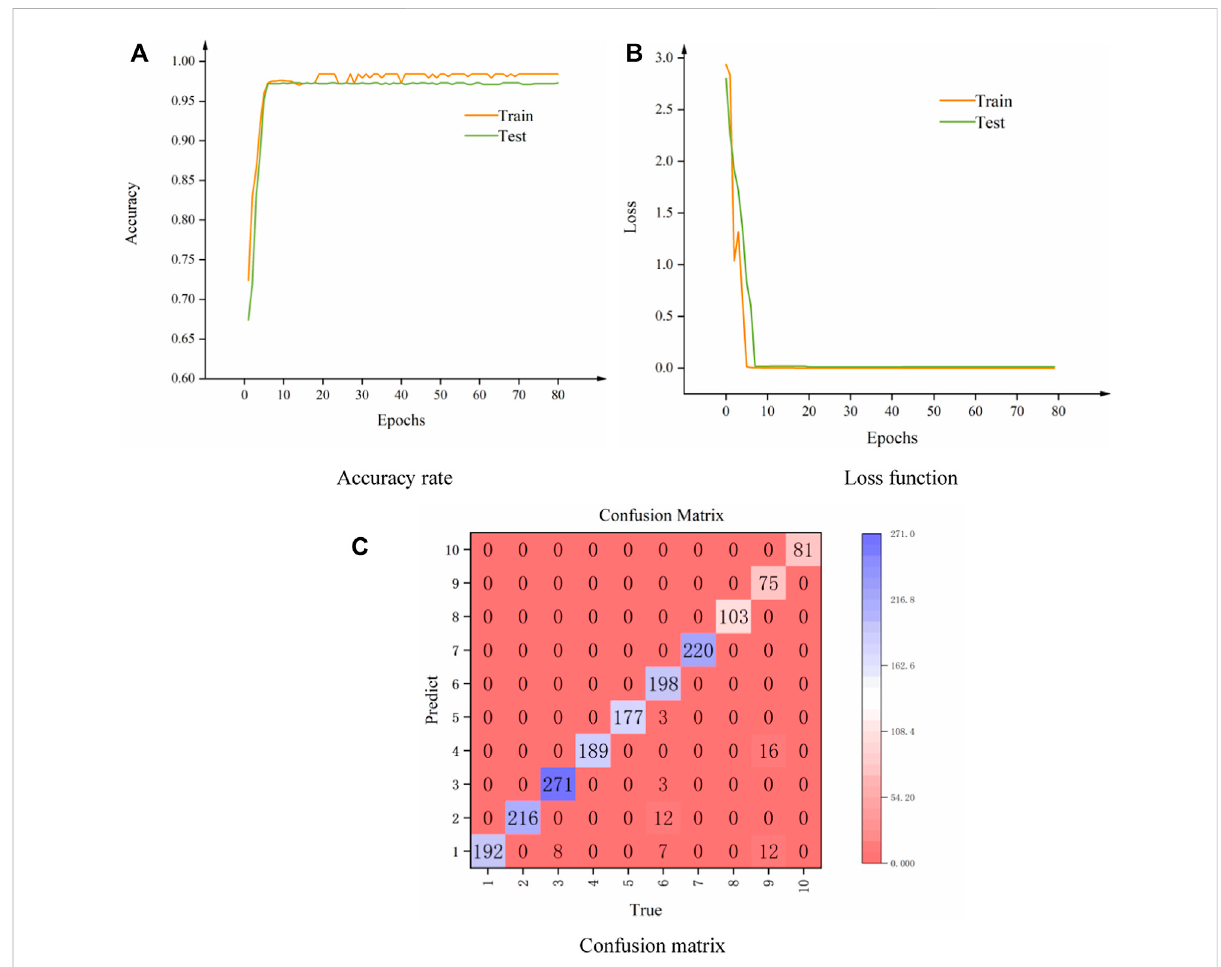
FIGURE 2 AlexNet training process. (A) Accuracy rate (B) Loss function (C) Confusion matrix.